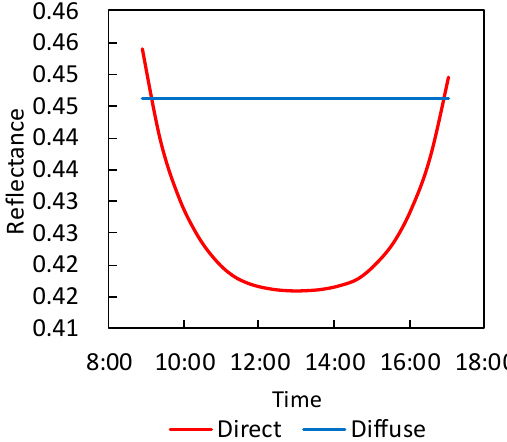
Figure 8. Simulated diurnal variation in direct and diffuse radiation canopy reflectance at 760.6 nm using the Soil Canopy Observation, Photochemistry and Energy fluxes (SCOPE) model for an LAI of 4 and spherical leaf inclination distribution function (LIDF).